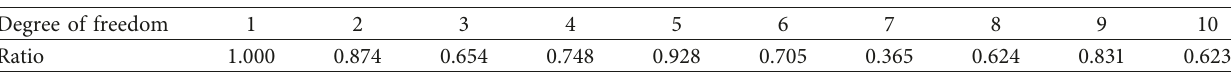
Table 9: The ratios of the 2 norms of the acceleration of all degrees of freedom to that of degree of freedom 1. Degree of freedom 1